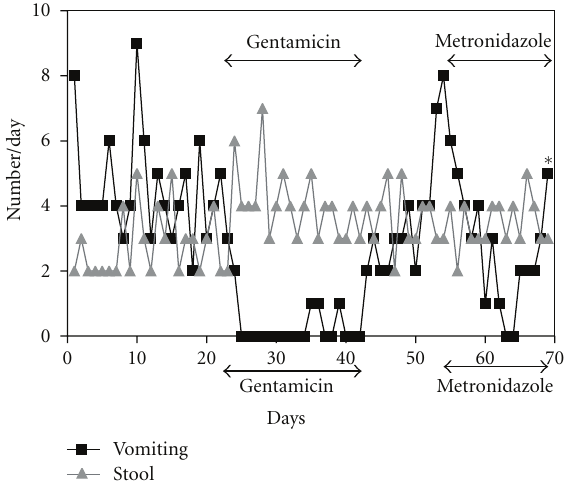
Figure 2: The clinical response of the patient to enteral gentamicin therapy. Duodenal biopsies were obtained on day 21, before the initiation of gentamicin, and on day 42, the last day of the therapy. Metronidazole was given 12 days after gentamicin to assess for the e ff ect of an antibiotic frequently used to treat small bowel bacterial overgrowth, but without pharmacogenetic